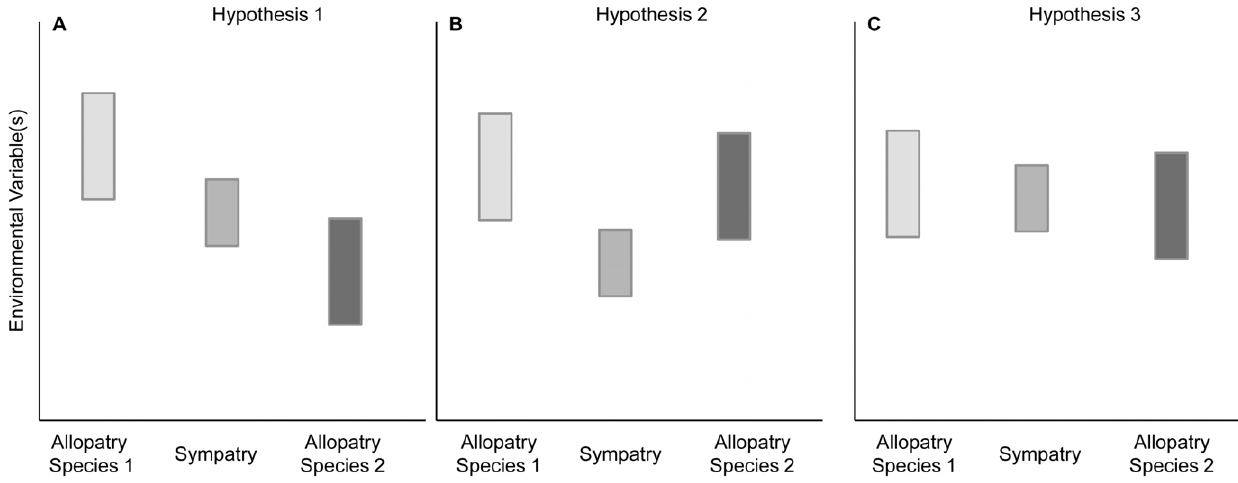
Figure 1. Alternative hypotheses for abiotic conditions underlying species distributions. A representation of three alternative patterns of environmental variation underlying sympatric and allopatric populations of two species across an environmental gradient. (a) Under hypothesis 1, species co-occur at intermediate environmental conditions where niches of the two species overlap. (b) Under hypothesis 2, biotic factors mediate co-occurrence such that species co-occur most commonly under extreme conditions. (c) Under hypothesis 3, sympatry and allopatry are governed primarily by dispersal ability, resulting in no environmental differences between sympatric and allopatric populations.